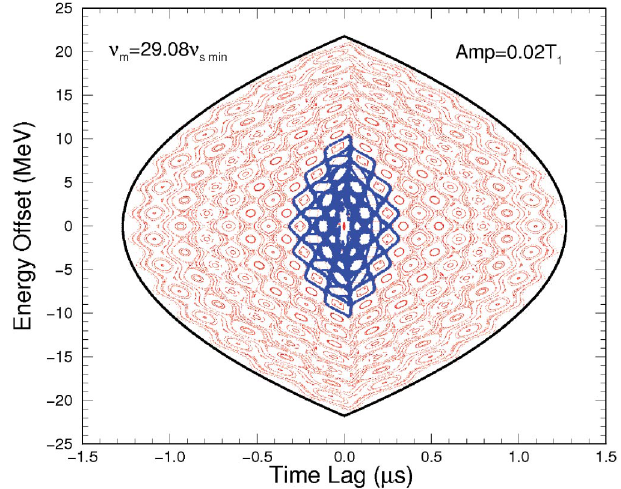
FIG. 8. (Color) Poincare´ section showing the phase modulation (cid:1) 0 : 02 T (cid:1) and modulation tune (cid:4) with amplitude aT m 1 1 (or modulation frequency 60 Hz). The simulations 29 : 08 (cid:4) s; min was performed with 50 particles equally spaced on the time- advance axis and tracking for 5 (cid:3) 10 6 turns. Particles clustered around the center of the bucket (blue dots) j (cid:5) j (cid:9) 0 : 035 (cid:1) s and (cid:1) E (cid:1) 0 are seen to diffuse towards j (cid:5) j (cid:13) 0 : 31 (cid:1) s , indicating a sea of